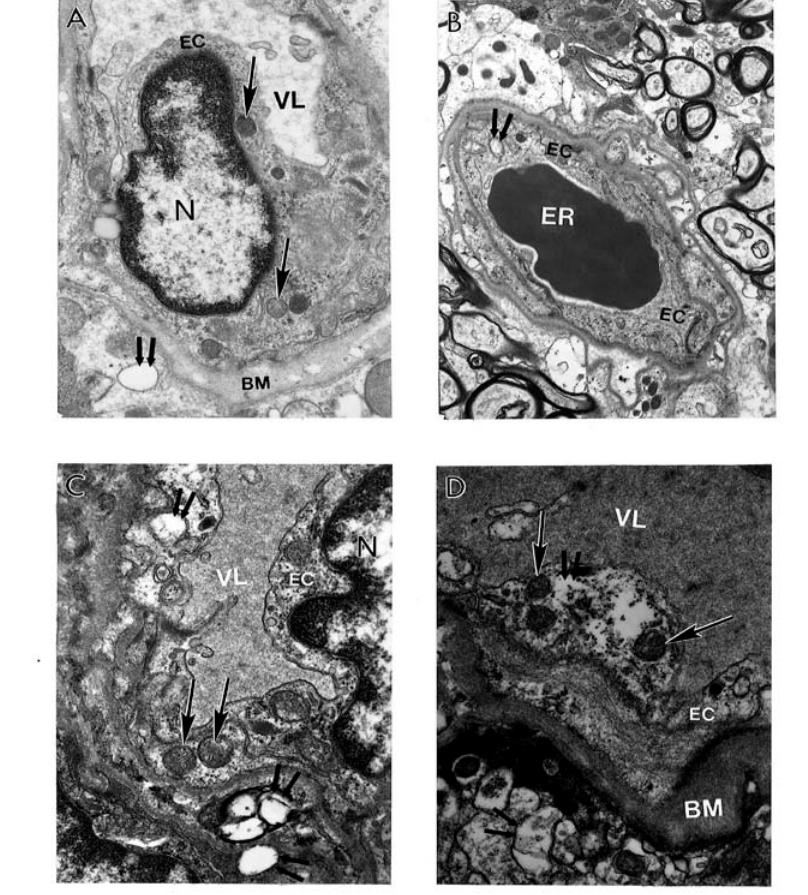
Figure 2. Ultrastructural features of brain microvessels from AD brains characterized by heterogeneous morphology. mitochondria abnormality appeared A. Undamaged microvessel endothelium did not show any particular changes in their ultrastructure. Mitochondria also were intact (single arrows). However, the perivascular spaces contained large vacuolar structures (double arrow). Original magnification X 13,000. B. Vascular EC shows the presence of degenerative mitochondria (double arrow). Original magnification X 6,600. C. The presence of electron-dense hypoxic mitochondria (single arrows) coexists with the formation of mitochondria derived lysosomal structure in the cytoplasmic matrix of EC and perivascular cells (indicated by double arrow). Original magnification X 20,000. D. To be a permanent feature of vascular endothelium and perivascular cells where damage became visible (single and double arrows indicate hypoxic and completely damaged mitochondria, respectively). Original magnification X 20,000. Abbreviations used in figures: BM–basal membrane of endothelium; EC–endothelial cell; ER–erythrocyte; VL– vessel lumen (reprinted from [87] with